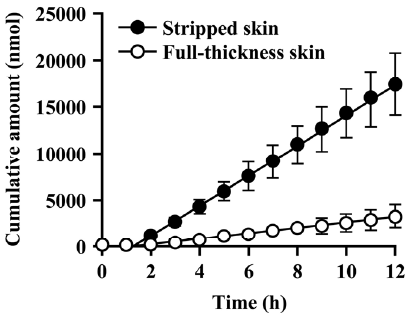
Figure 6. Permeation profile of PL across stripped skin and full-thickness skin after application of PL. Open and closed symbols show the amount of PL transported into the receiver side across full-thickness and stripped skin, respectively. Each value represents the mean ± S.D. ( n = 6).